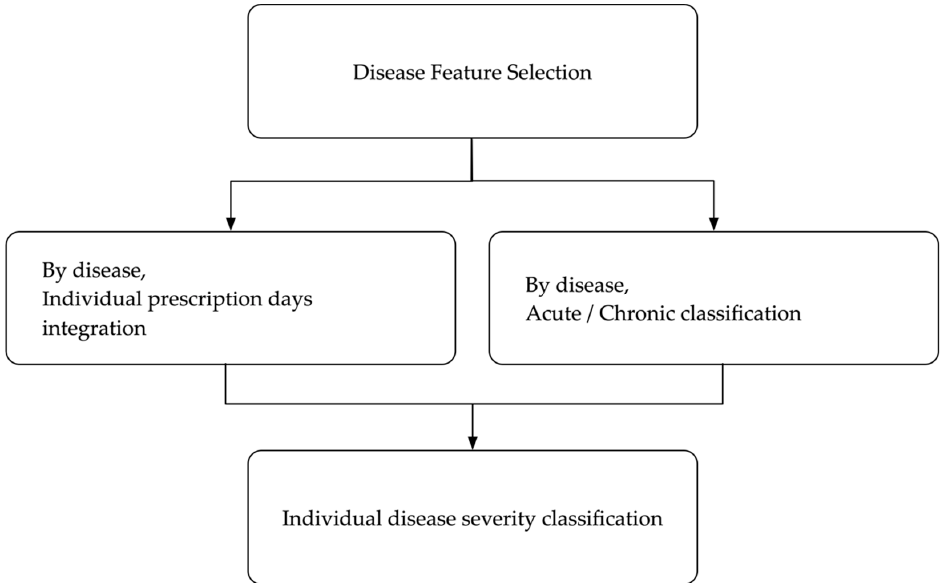
Figure 2. Flowchart of the dis ease severity classification algorithm.